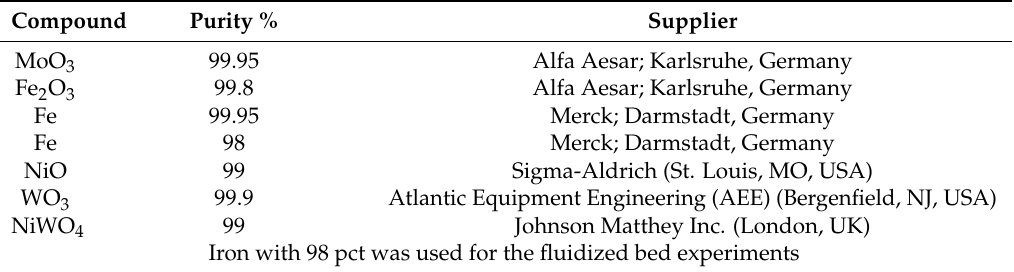
Table 1. Starting materials, their purity and corresponding